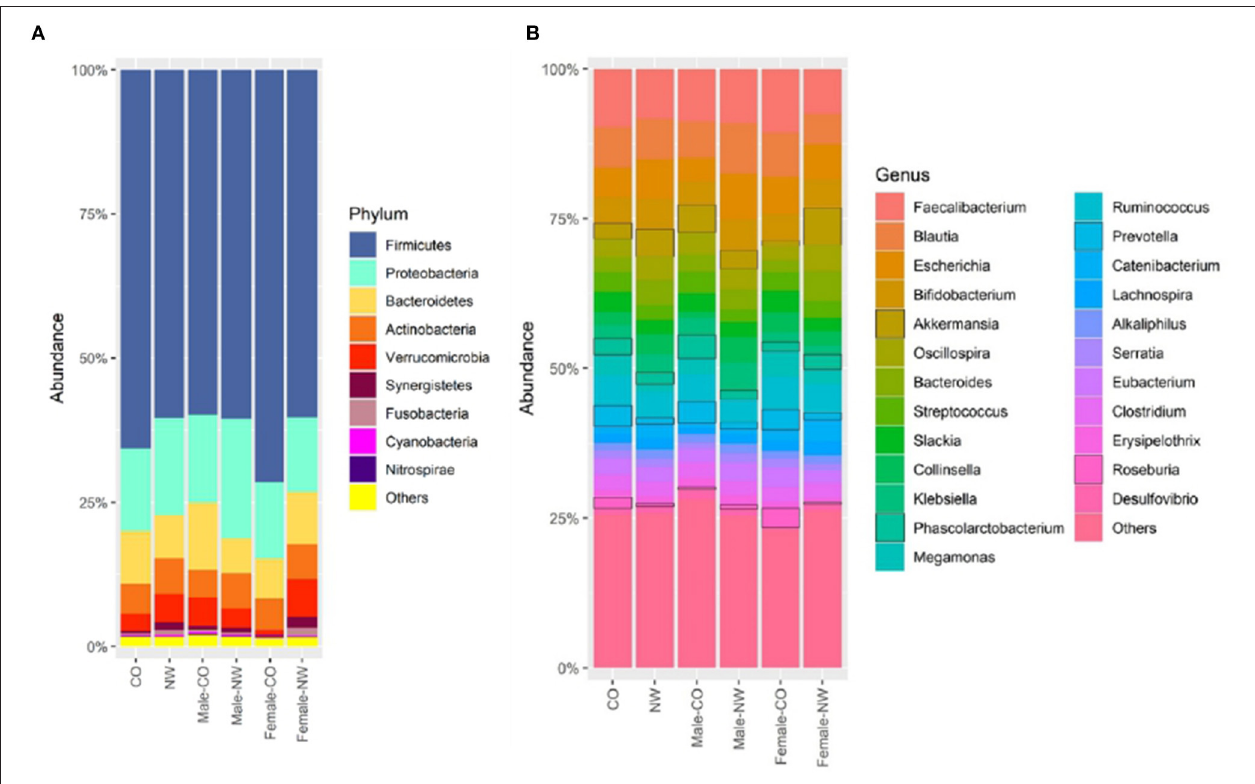
FIGURE 2 | Relative abundance of operational taxonomic units (OTUs) of the gut microbiota of central obese (CO) and normal weight (NW) subjects at (A) phylum and (B) genus